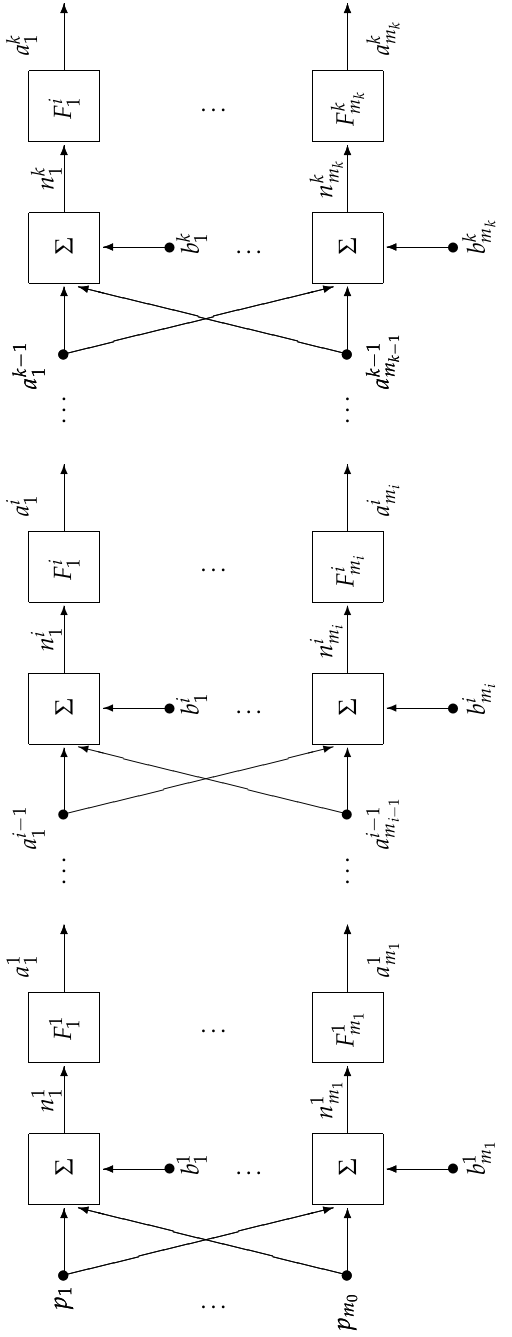
Figure 4. IFNN with many layers with many multi-input neurons.